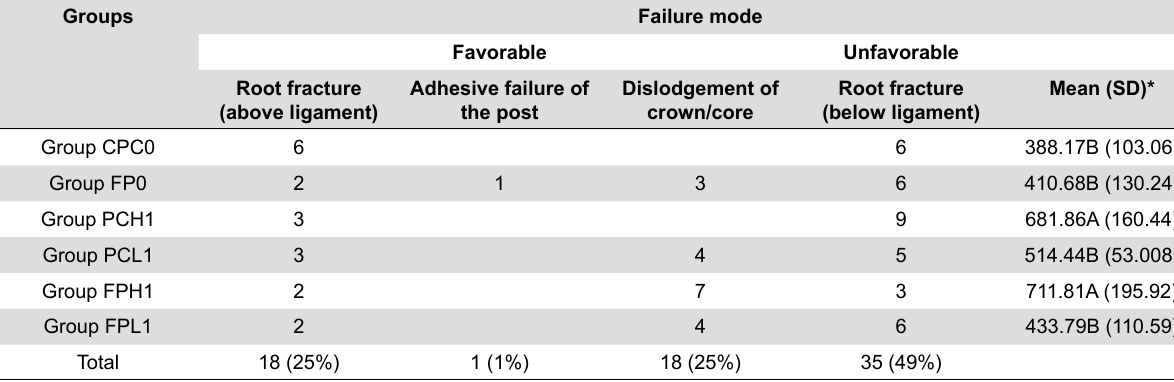
Table 1- Distribution of the failure modes occurred during mechanical cycling and after load to fracture test. Mean and standard deviation (Newton) of values for Groups